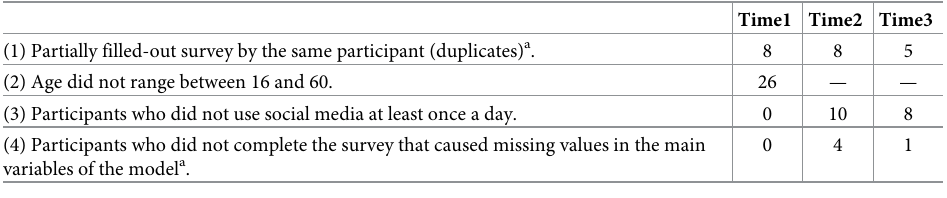
Table 1. Data exclusion